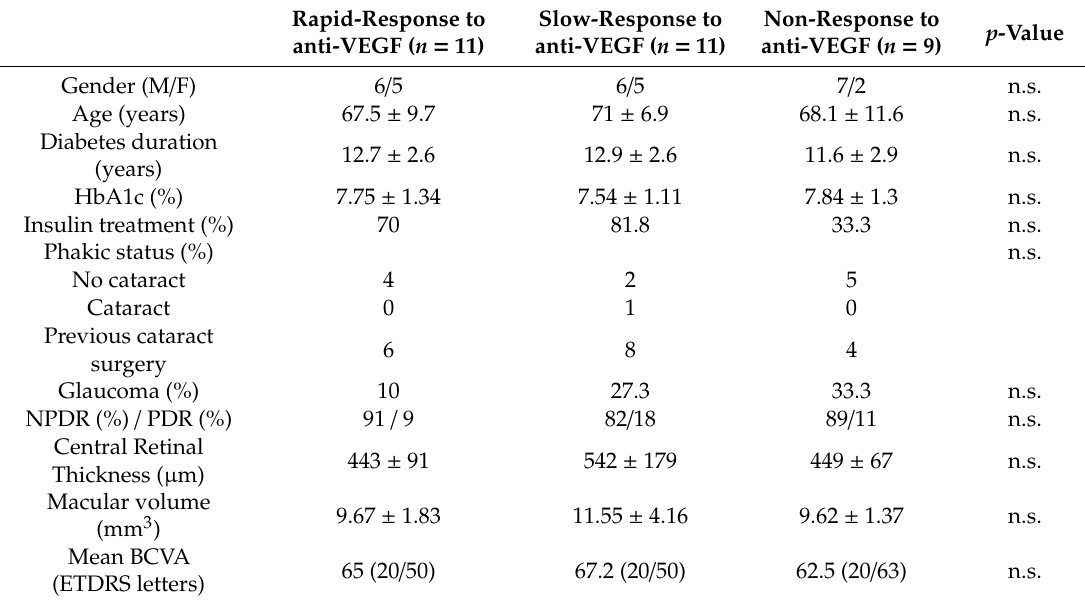
Table 2. Characteristics of diabetic patients treated with anti-VEGF agents.